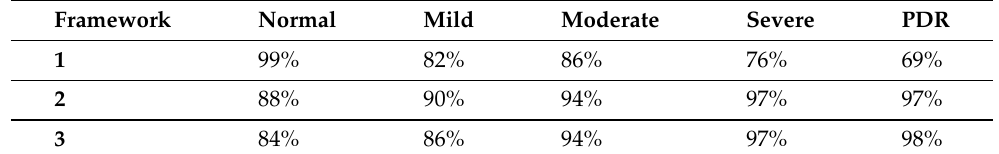
Table 12. Class-wise comparison of accuracy between frameworks.